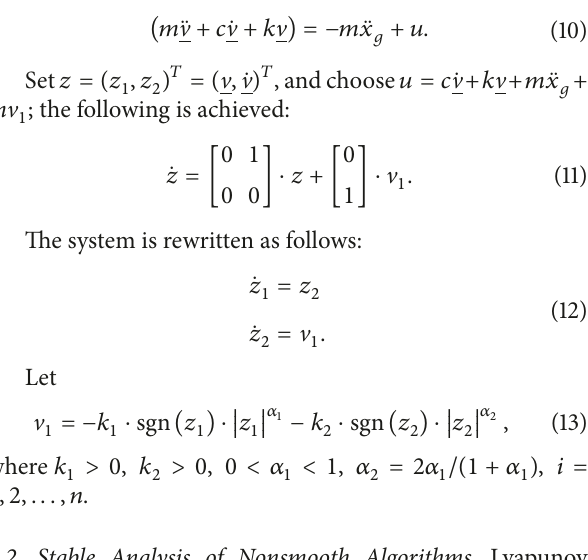
Figure 1: Seismic